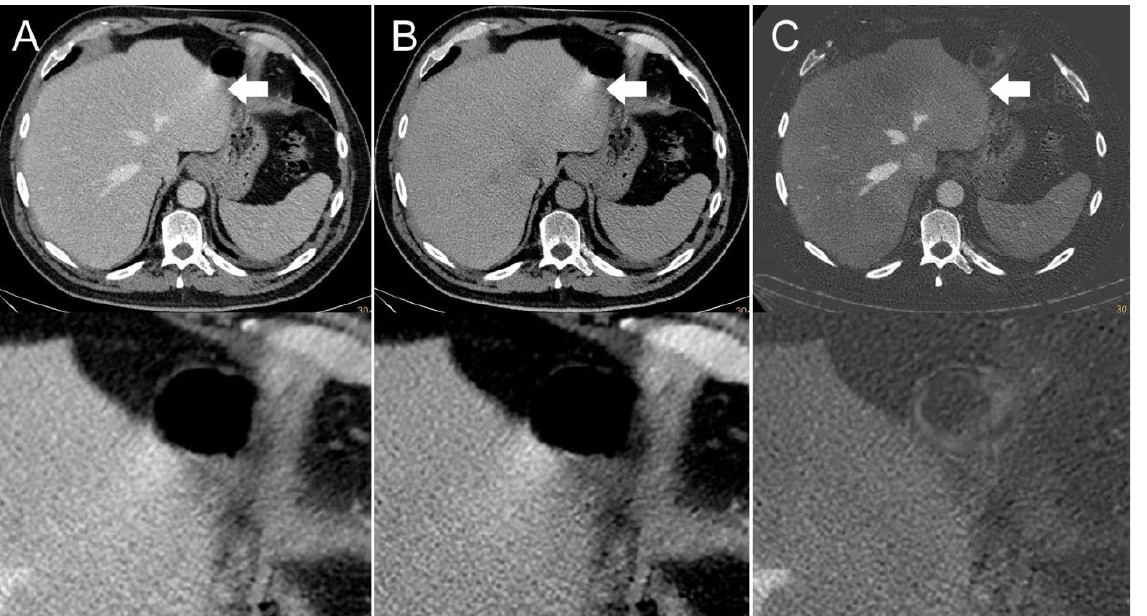
Figure 1. Flow diagram of the study population. CT (Computed tomography). The presence of visible intestinal peristalsis-related streak artifacts on the liver was significantly lower ( p < 0.001) in the iodine image reconstructions with 18/208 (9%) compared with the conventional 120 kVp images with 51/208 (25%) (see Figures 2–4). The presence of visible peristalsis-related streak artifacts on the liver was not significantly lower in 40 keV monoenergetic image reconstructions with 48/208 (23%) ( p = 0.15), 200 keV monoenergetic image reconstructions with 51/208 (25%) ( p = 1.0), or VNC image reconstructions with 50/208 (24%) ( p = 1.00) compared with conventional 120 kVp images.